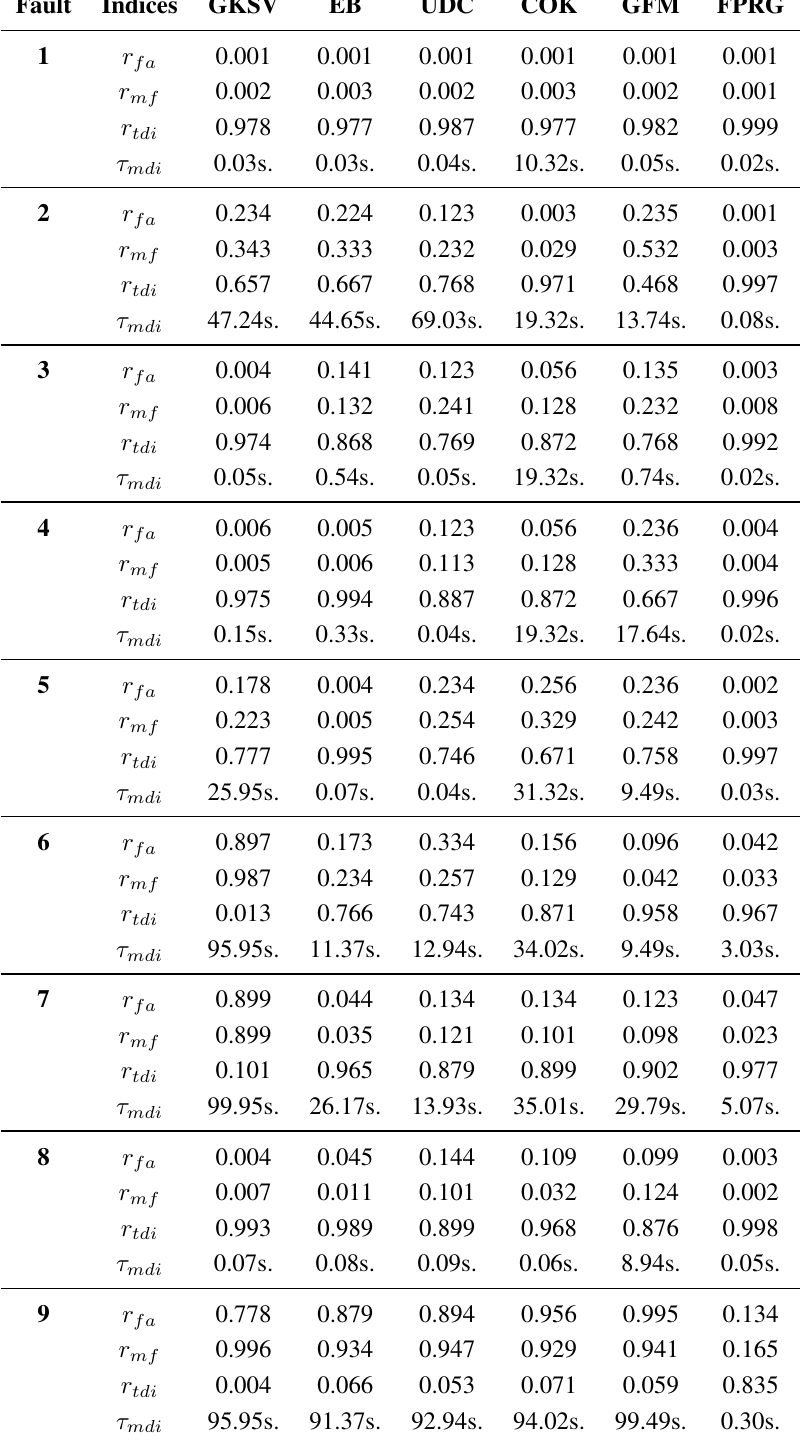
Table 7. Comparison of the considered FDI strategies. GKSV, Gaussian kernel support vector; EB, estimation-based; UDC, up-down counter; COK, combined observer and Kalman filter; GFM, general fault model; FPRG, fuzzy predictors as residual generators.